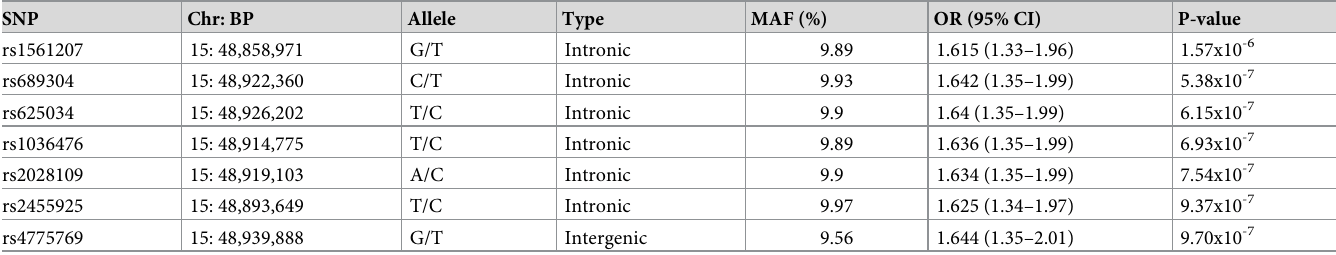
Table 4. Linkage group of FBN1 variants associated with thoracic aortic aneurysm.